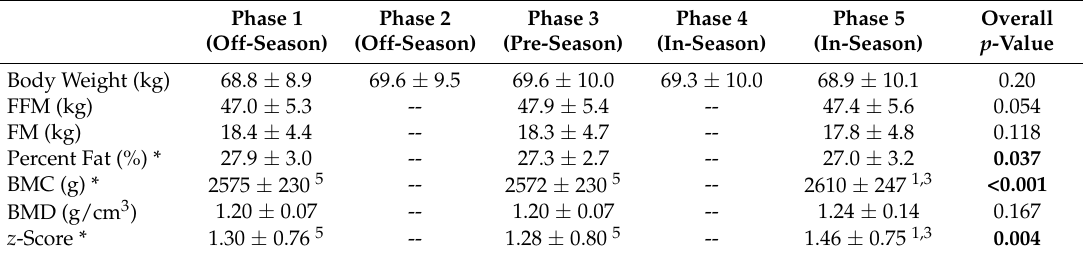
Table 1. Body Composition and Bone Health over the Academic Year.